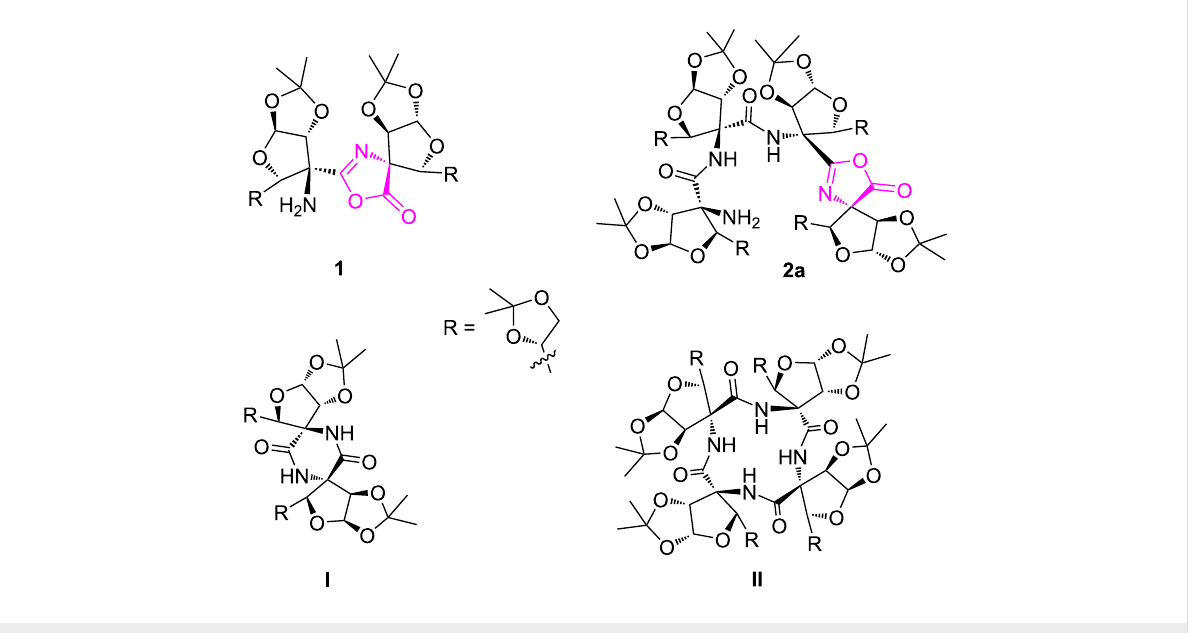
Figure 1: Oxazolone pseudodipeptide 1 and tetrapeptide 2a .